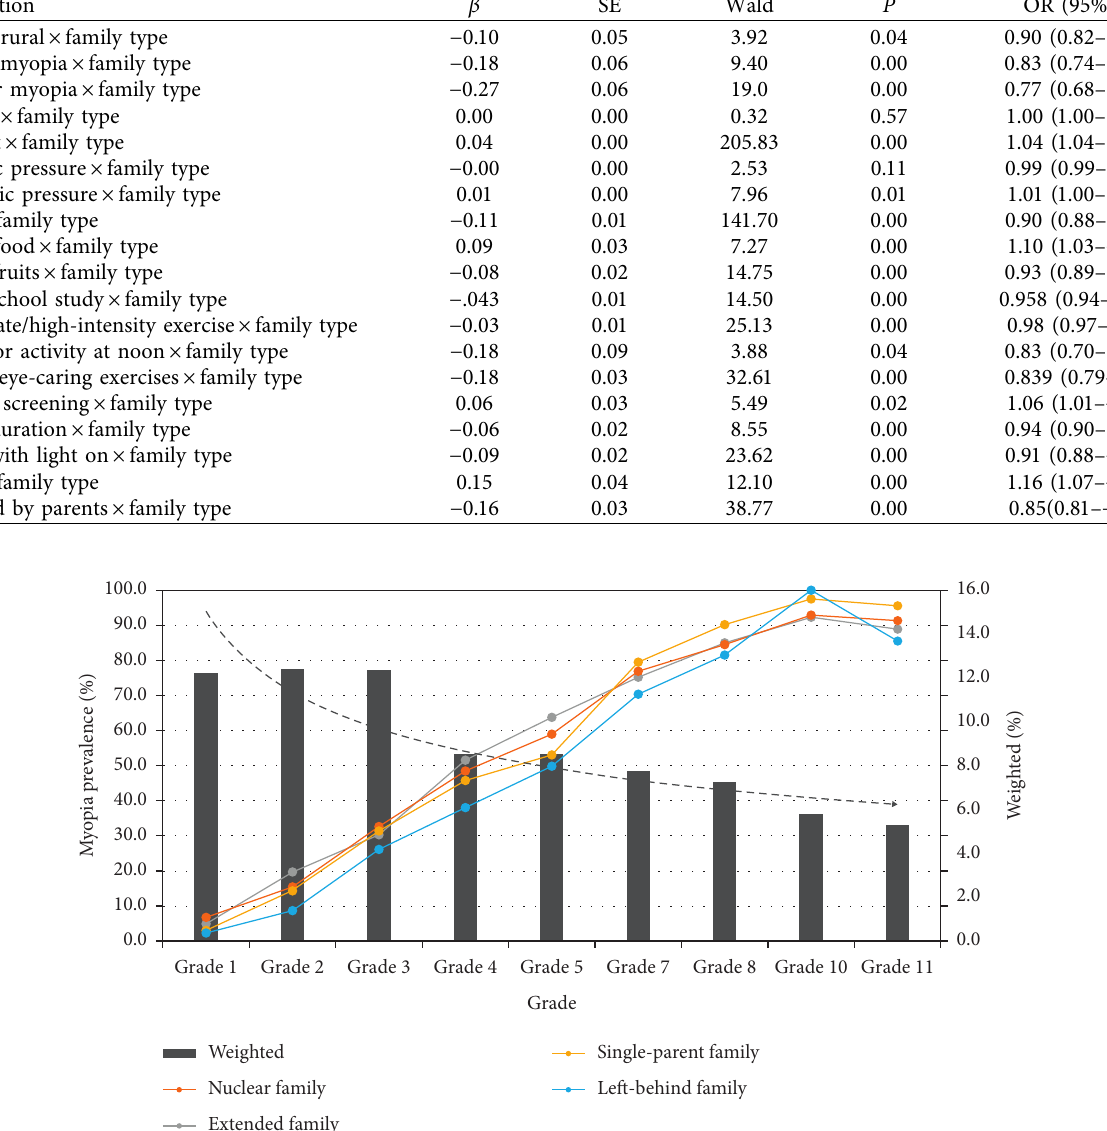
Figure 1: Prevalence of myopia of different grades in different family types.